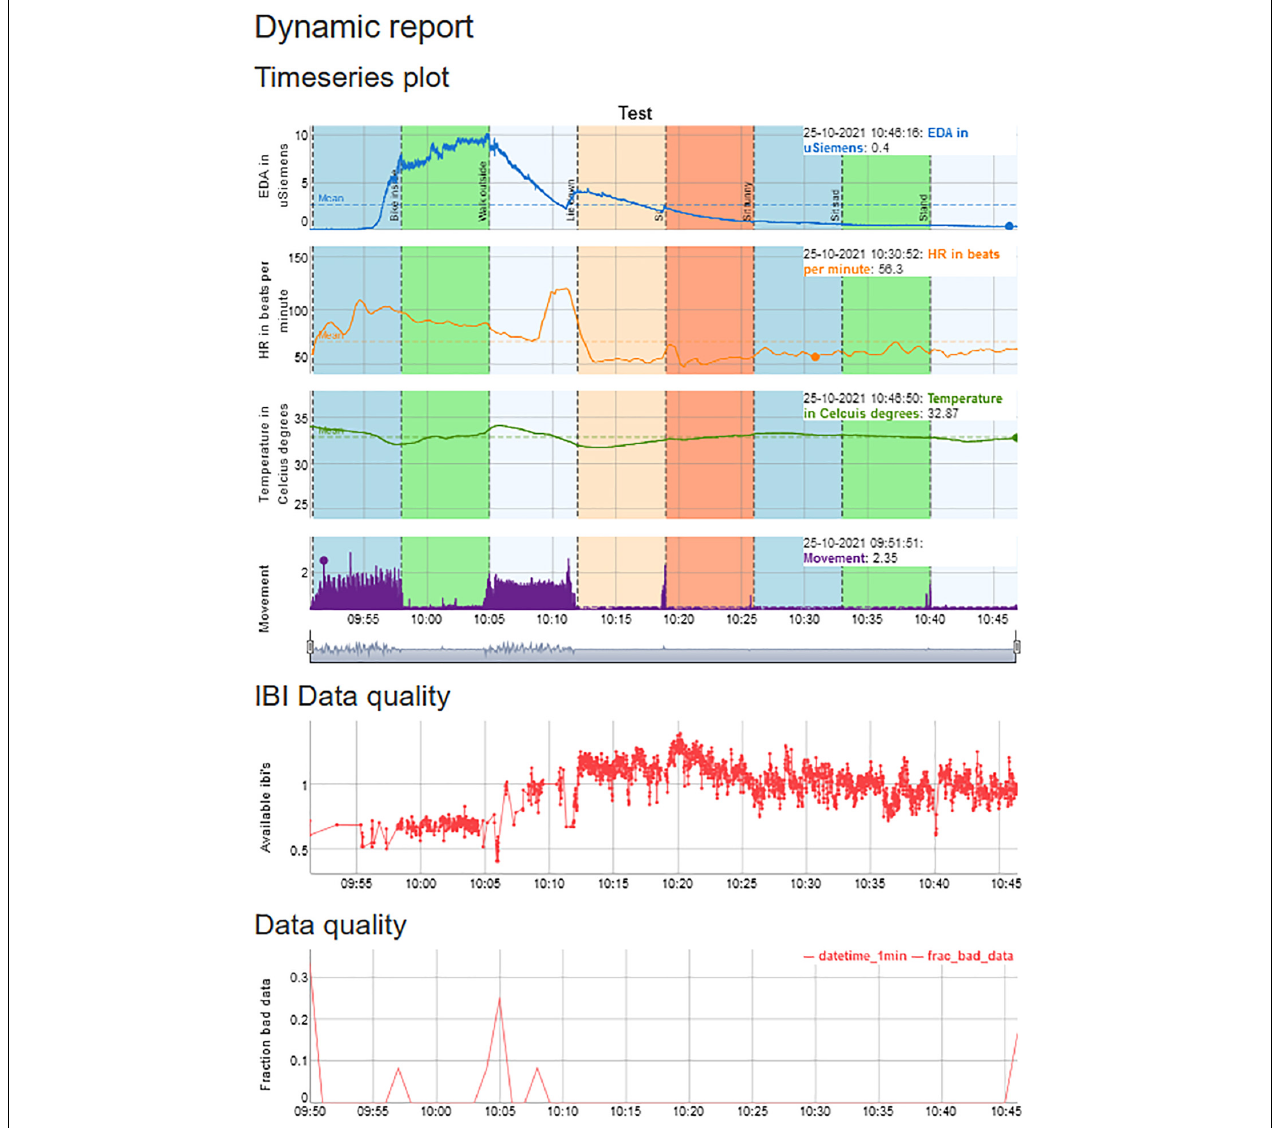
FIGURE 1 | An example of a session that contains physiological data on EDA, HR, temperature, and movement, but also provides information from HR, movement, and EDA on the number of